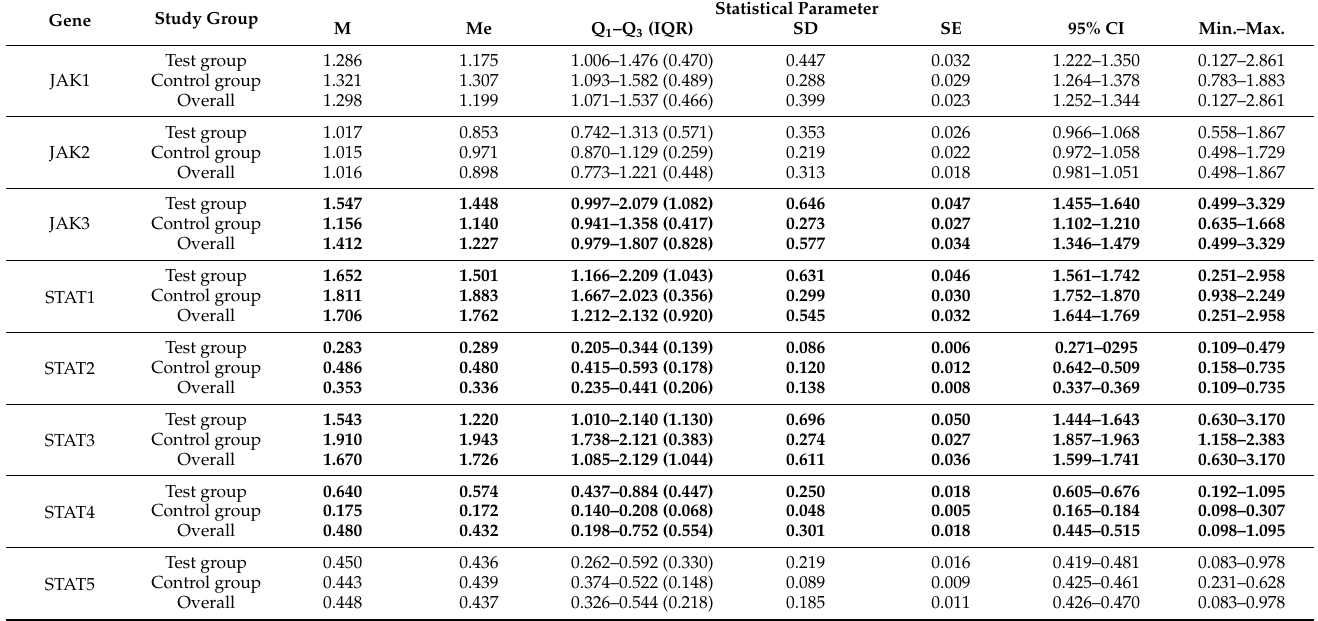
Table 3. Detailed descriptive statistics for gene expression at the protein level (ng/mL) by study